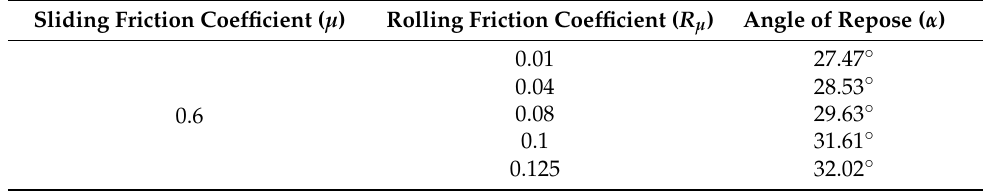
Figure 5. Simulation of angle of repose for sandpile. Table 5. Angle of repose for various friction coefficients. Table 5. Angle of repose for various friction coefficients.